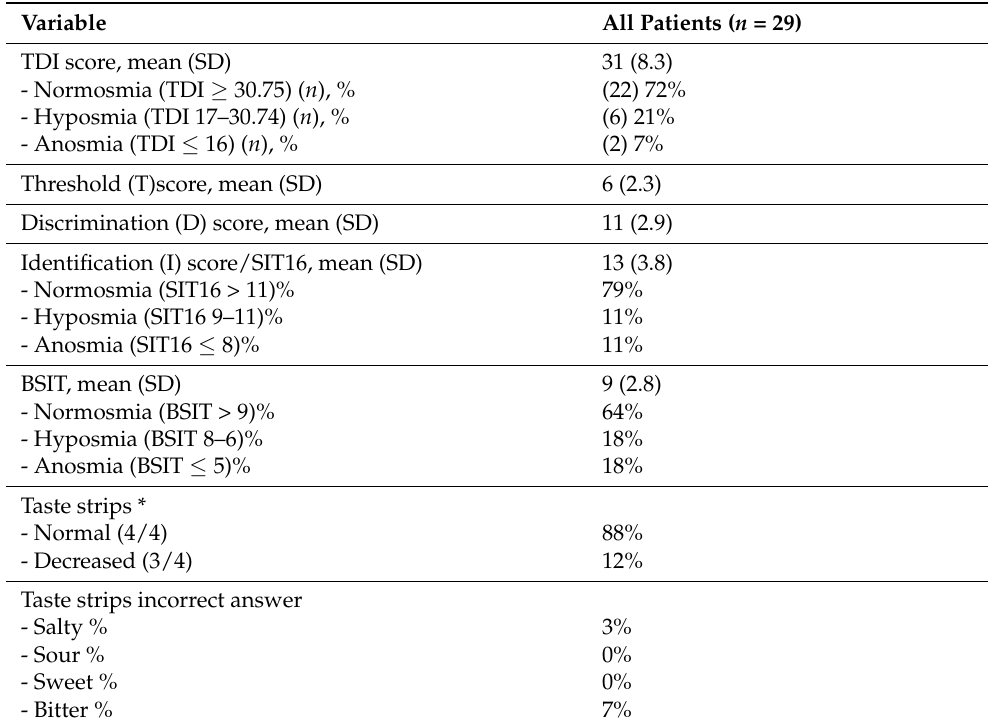
Table 2. Psychophysical olfactory and gustatory test results 3–6 months after hospitalisation for COVID-19.